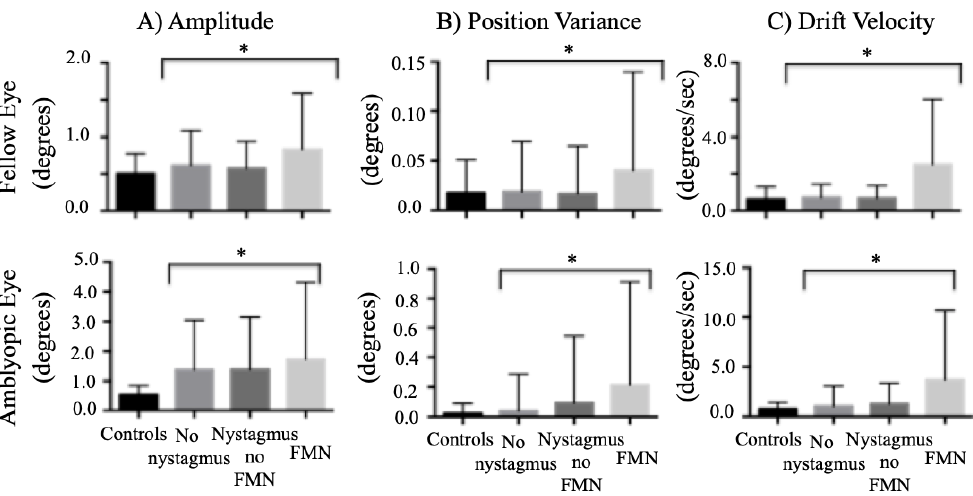
Fig. 5: Mean and standard deviation of eye movement parameters of fixational saccade amplitude, position vari- ance, and drift velocity in subjects across eye movement waveforms under fellow and amblyopic eye viewing condi- tions. Error bars represent one standard deviation. Composite amplitude (A) of fixational saccades in controls and pa- tients without nystagmus and quick phases of patients with nystagmus shows increased amplitude in amblyopes under both fellow and amblyopic eye viewing. Similarly, position variance (B) of drifts in controls and patients without nys- tagmus and slow phases of patients with nystagmus is also increased. The drift velocity (C) in controls and patients without nystagmus and slow phase velocities in patients with nystagmus is also increased in amblyopes compared to